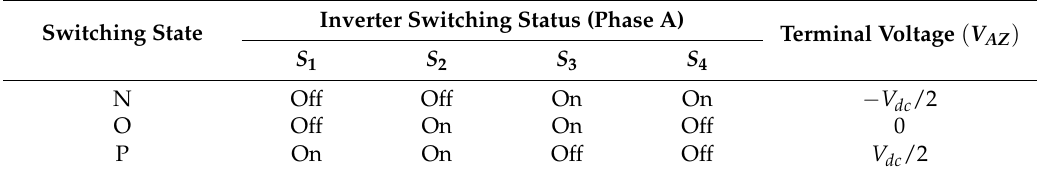
Table 2. Switching states representation for a three-level NPC inverter